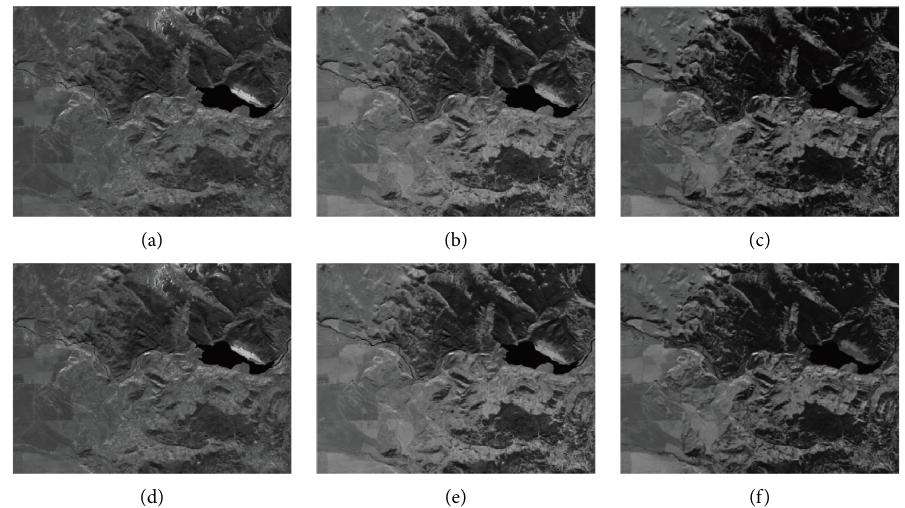
Figure 2: Original Yellowstone scene 00 (a) frame 50 (b) frame 100 (c) frame 150 reconstructed Yellowstone scene 00 with CR �